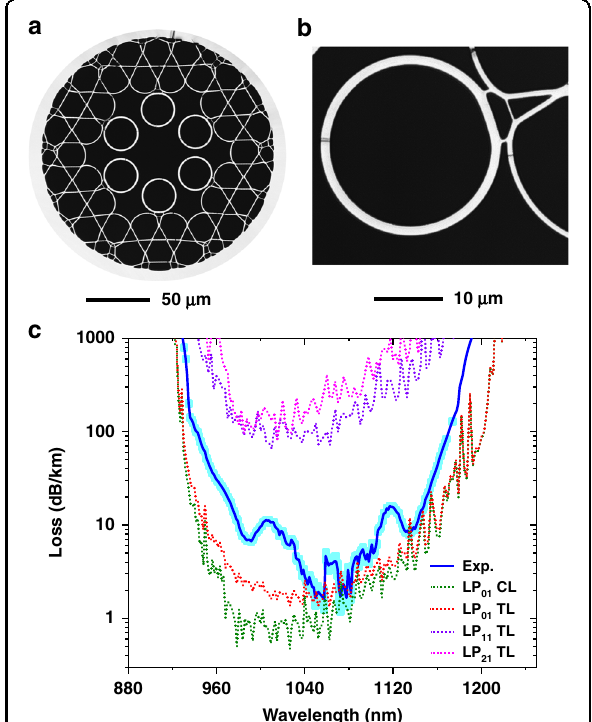
Fig. 5 Fabricated Hybrid Kagome-tubular HCPCF. a HKT-HCPCF cross-section and b enlarged view of the supporting tube region. c Cutback measurement results (blue curve), simulated CL and TL for the fundamental mode (green and red dotted lines, respectively), and the simulated TL for representative higher-order modes (purple and pink dotted lines)